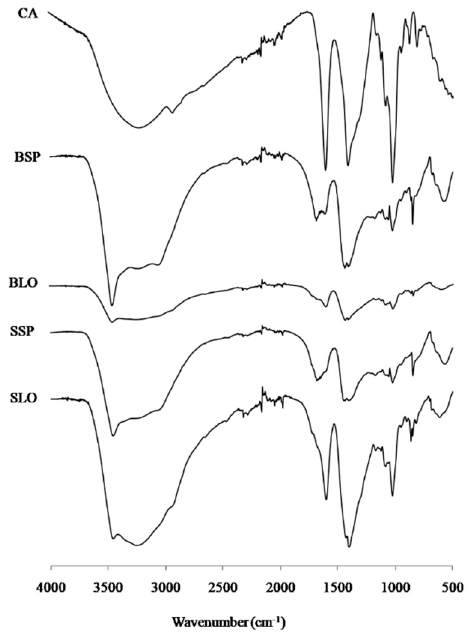
Figure 1. FT-IR spectra of commercial sodium alginate (CA) and alginates extracted from the blades L. ochroleuca (BLO), stipes of L. ochroleuca (SLO), blades of S. polyshides (BSP), and stipes of S. polyshides (SPS).